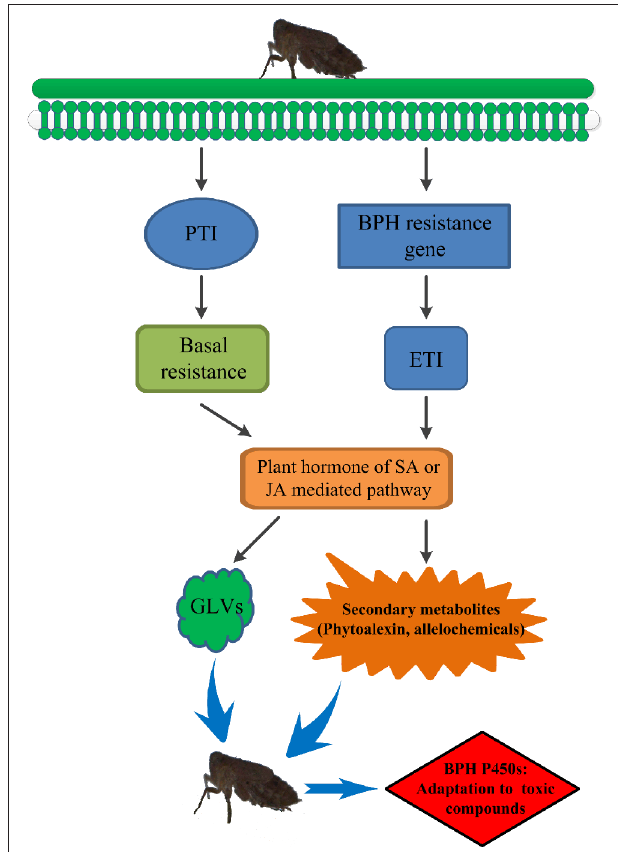
FIGURE 9 | The preliminary model of rice resistance via allelochemicals to drive evolution of BPH P450 enzymes. PTI, PRR (pattern recognition receptor)-triggered immunity; ETI, effector-triggered immunity; GLVs, green leaf volatiles. BPH feeding induces PRR-triggered immunity (PTI) and effector-triggered immunity (ETI). PTI is the basal immune status that is effective against a broad spectrum of pathogens or herbivores and induces the SA or JA signaling pathway. ETI triggers a series of BPH-mediated immune responses and profoundly promotes basal resistance, including inducing the SA or JA signaling pathway. Plant hormones such as SA or JA mediate phytoalexins or secondary metabolites to resist BPH infestation. BPH detoxifies allelochemicals to adapt to its host plant using its detoxification system consisting of the P450 family of